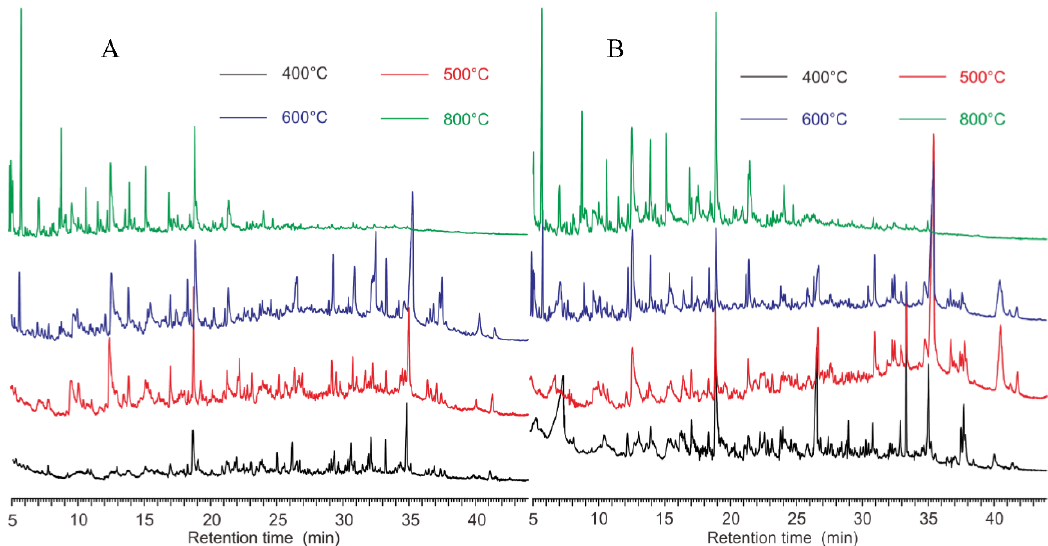
Figure 3. Pyrograms of S. aureu s ( A ) and E. coli ( B ) at four different temperatures.